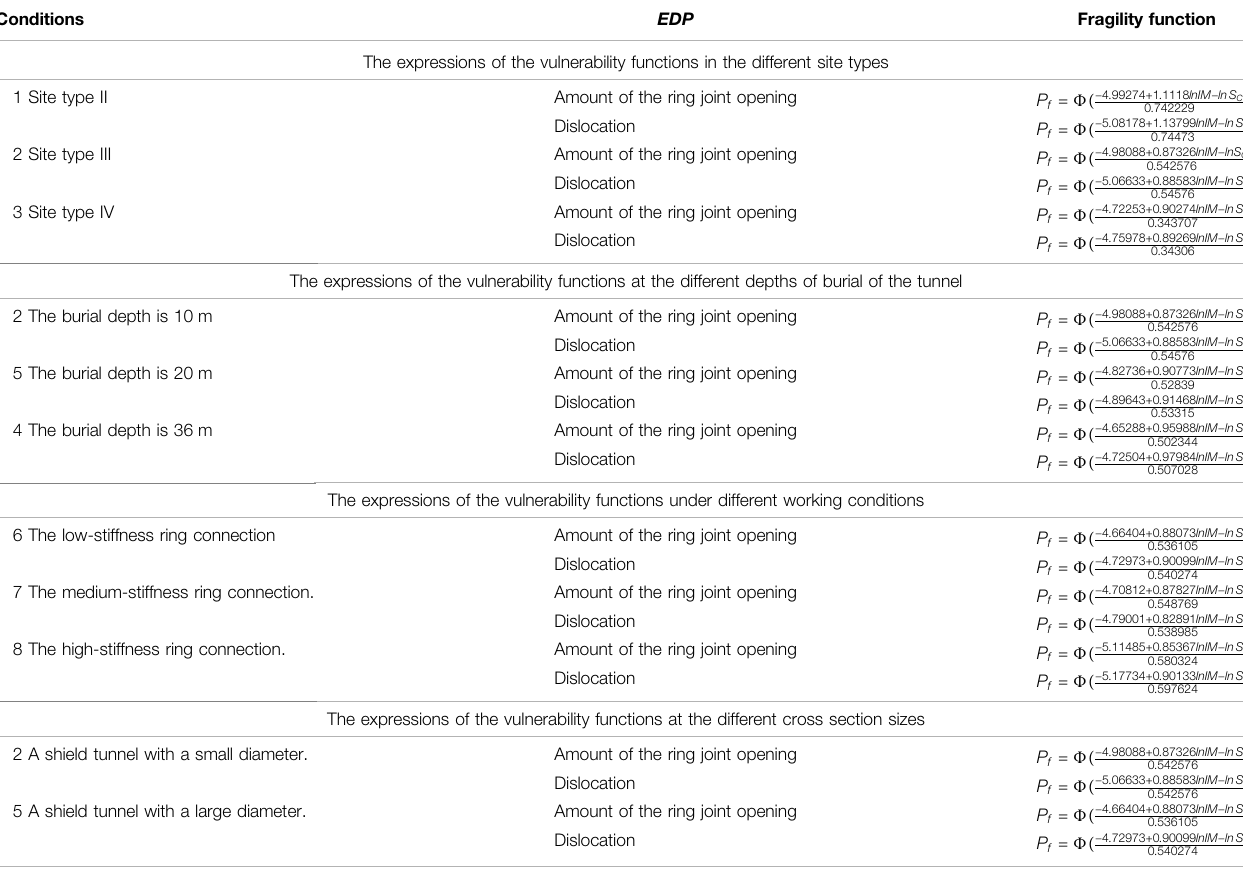
TABLE 4 | The expressions of the vulnerability